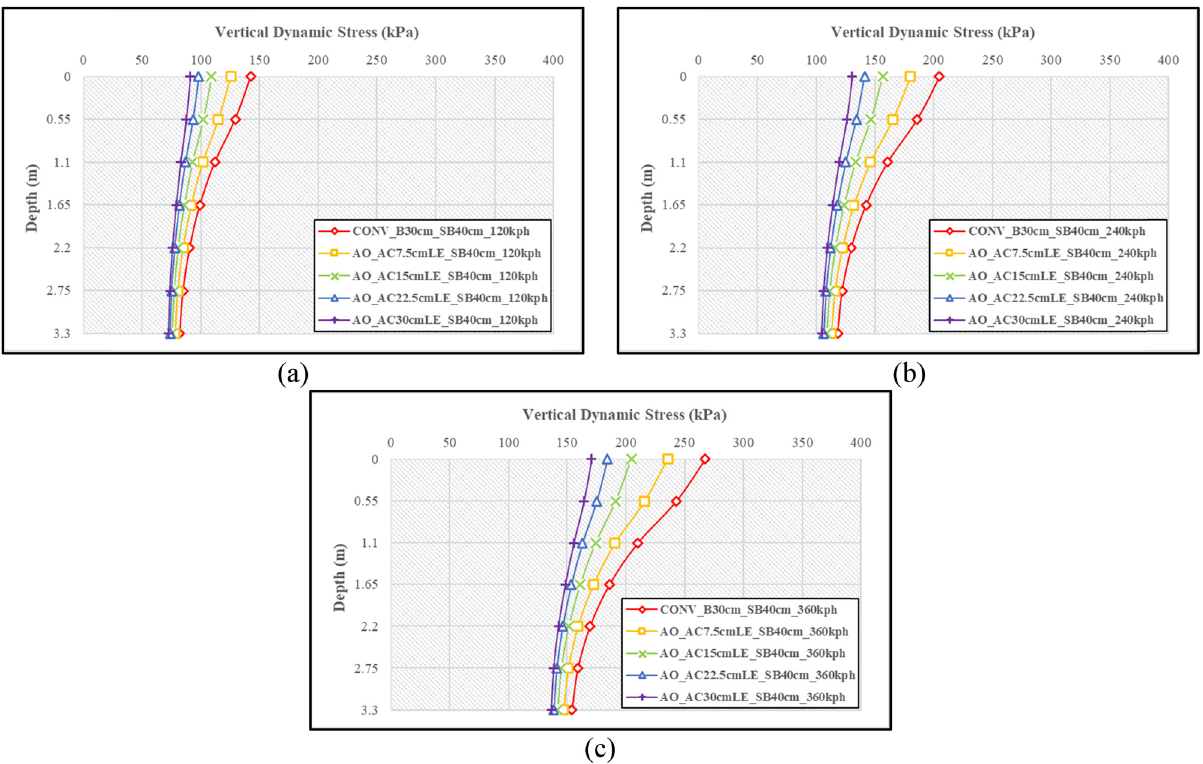
Figure 12: Vertical compressive stress curve in subgrade layer of Indonesia ’ s ballasted track and asphaltic overlayment track with 7.5, 15, 22.5, and 30 cm of AC layer: ( a ) 120 kph, ( b ) 240 kph, and ( c ) 360 kph.